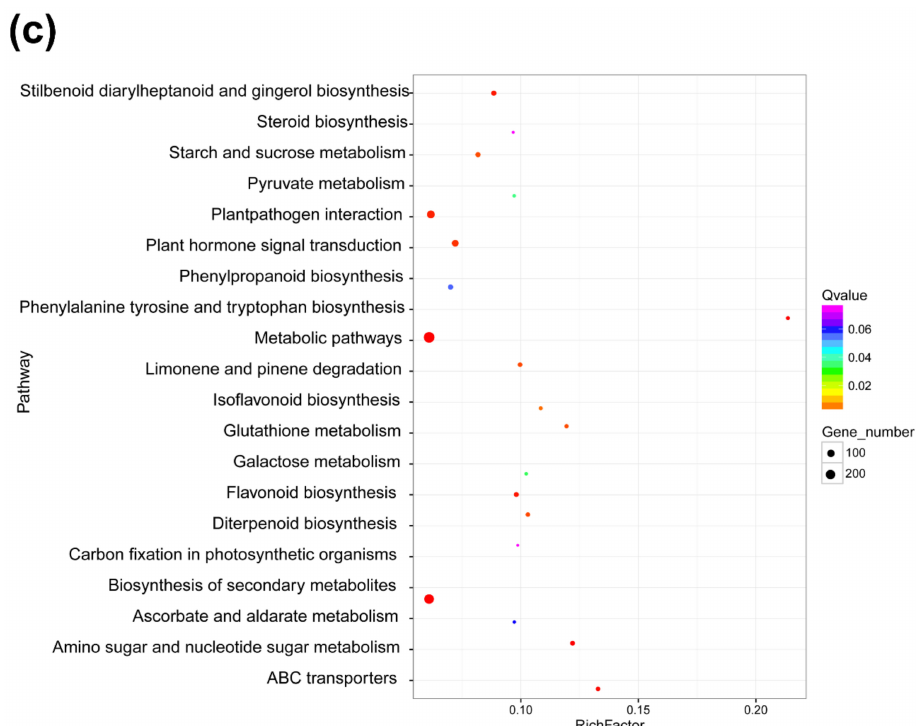
Figure 3. Gene ontology (GO) function enrichment analysis, GO terms, and KEGG pathway enrichment of DEmRNAs identified in RBSDV-infected rice plants. ( a ) GO enrichment analysis of DEmRNAs with a p -value < 0.05; ( b ) gene ontology terms for molecular function of DEmRNAs; ( c ) statistics of the top 20 KEGG pathways enriched for DEmRNAs. The size of each circle represents the number of significant DEmRNAs enriched in the corresponding pathway. The enrichment factor was calculated using the number of enriched DEmRNAs divided by the total number of background genes in the corresponding pathway. A pathway with a p -value < 0.05 is considered to be significantly